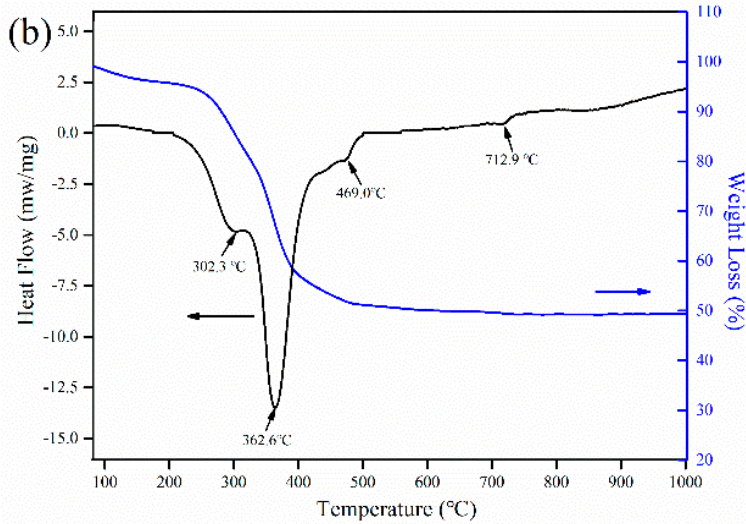
Figure 2. Analyses of the combustion products: ( a ) FTIR spectrum and ( b ) thermogravimetric and differential scanning calorimetry (TG-DSC) thermogram.